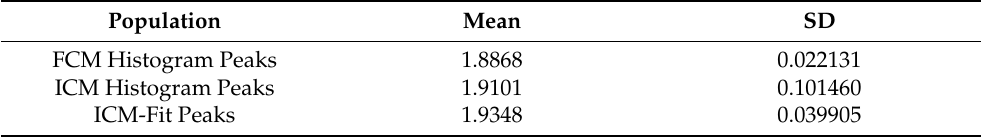
Table 3. Peak ratio properties of all of the samples